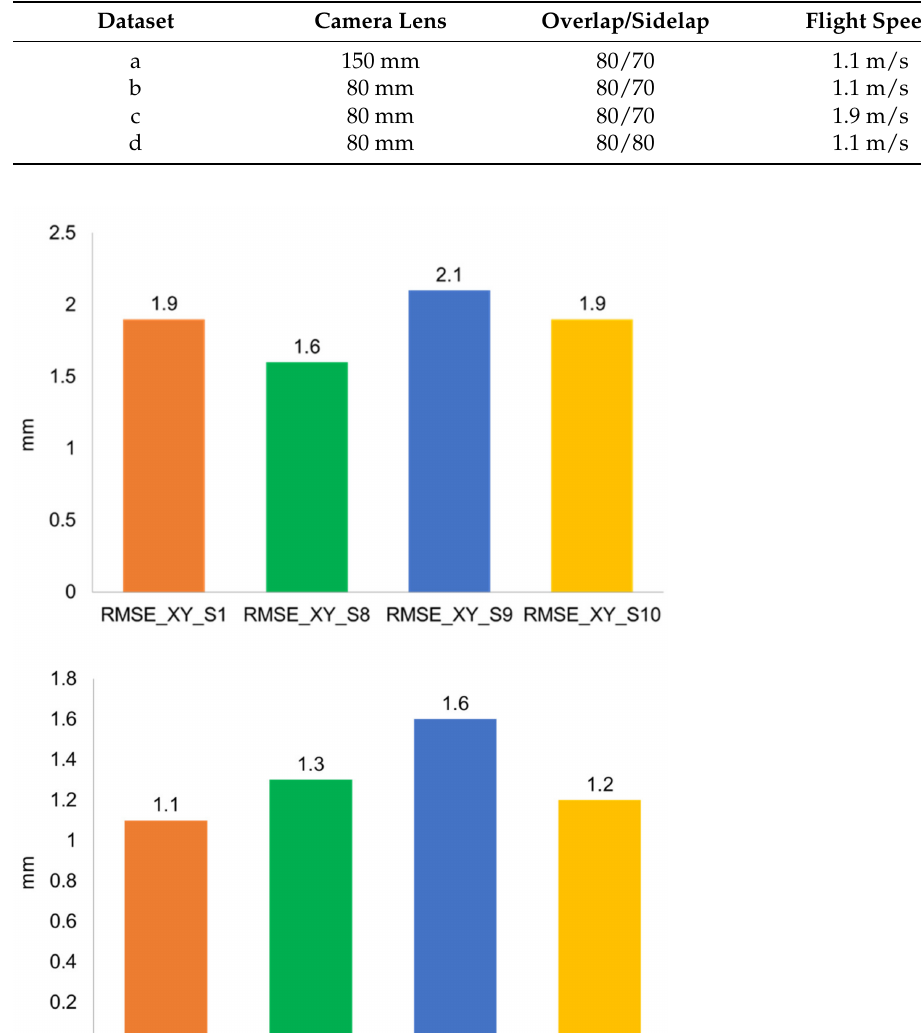
Table 3. Survey Area B Settings.